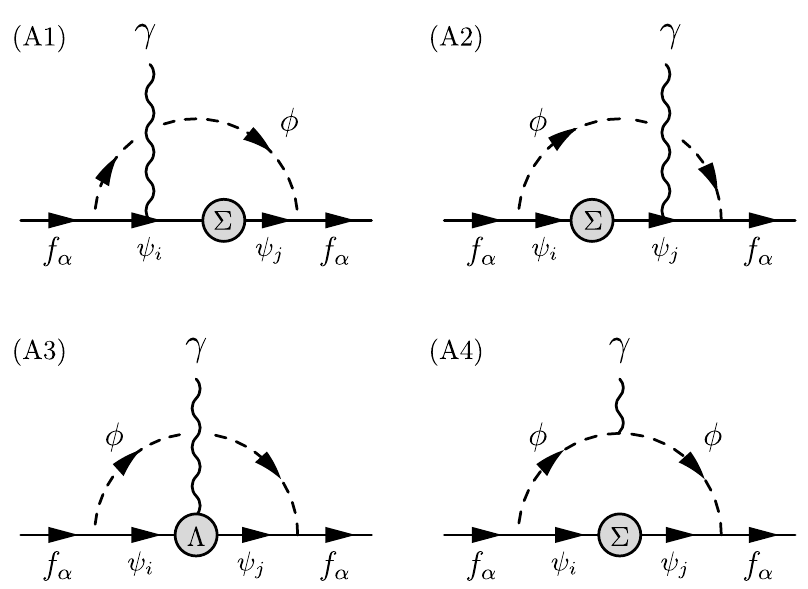
Figure 3 . Feynman diagrams potentially inducing non-zero EDMs of the fermion f α with the multi-fermions ψ and a scalar φ i